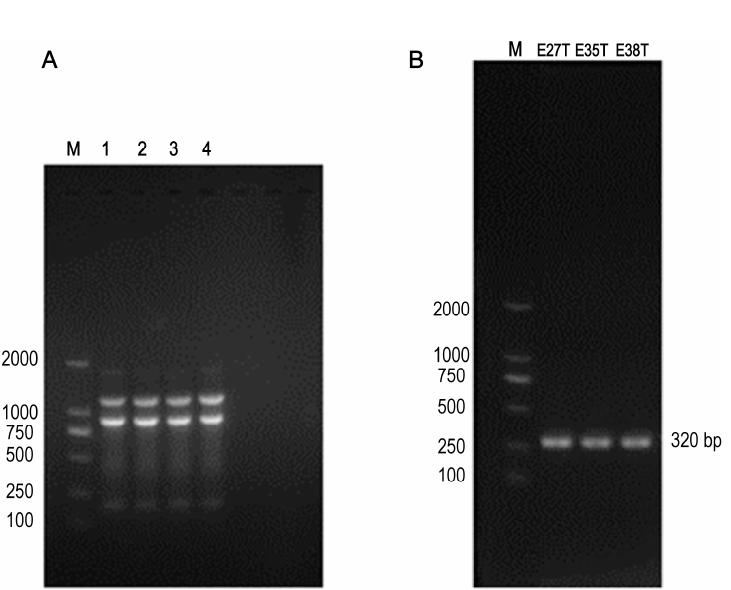
Figure 1. The ERIC-PCR and PCR results. ( A ) Lanes 1-3: transconjugants EC027/T, EC035/T and EC038/T, lanes 4: C600, M: 2000 DNA marker; The ERIC-PCR result of 3 transconjugants and C600,